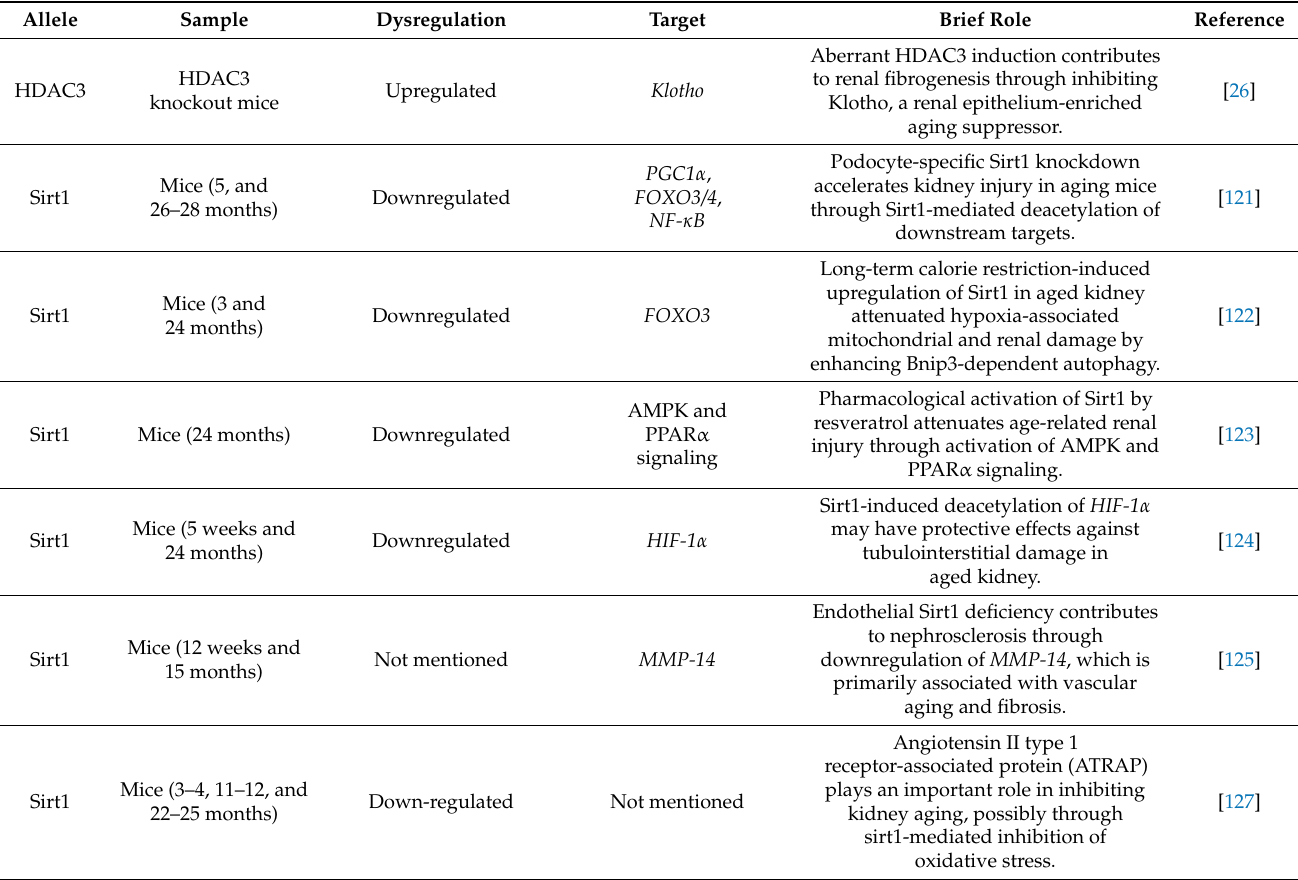
Table 2. Histone modifications in age-related kidney